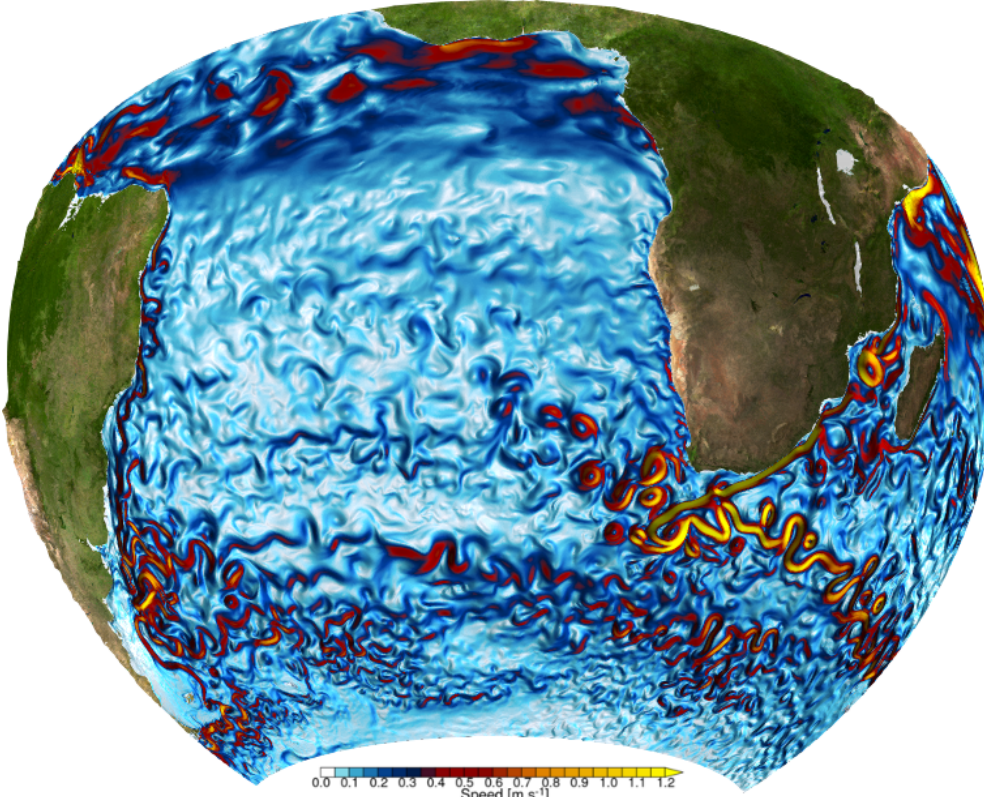
Figure 1. Snapshot of surface speed (in ms − 1 ) as simulated in the nested area of INALT20.